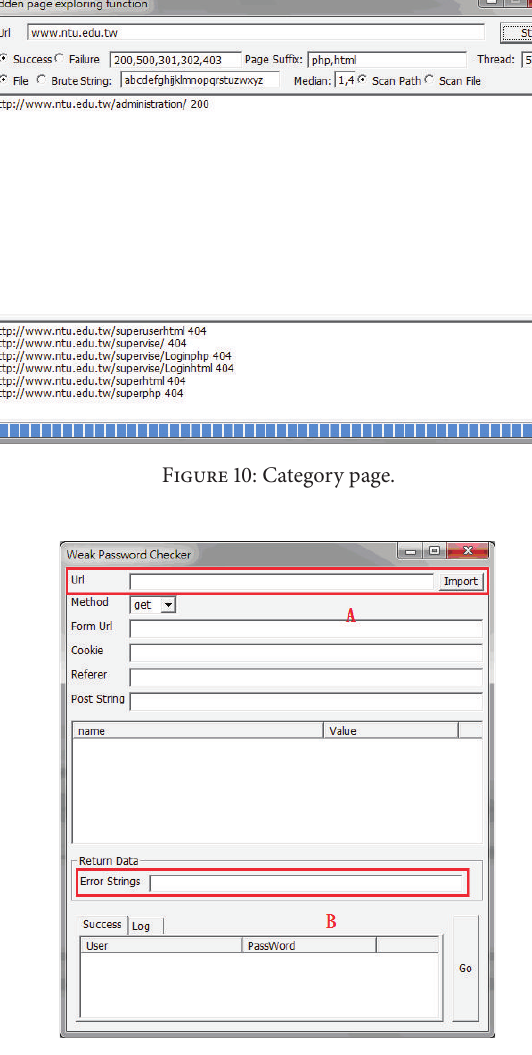
Figure 11: Interface for detecting a weak